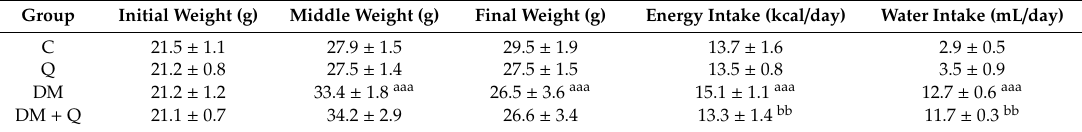
Table 1. E ff ect of quercetin on the changes of the body weight, energy, and water intake. Group